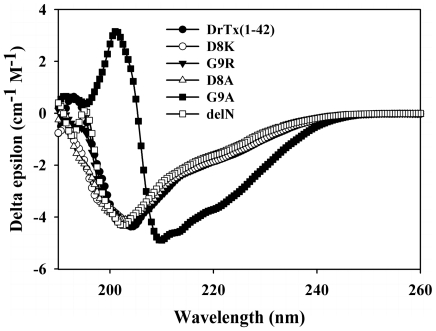
Circular dichroism spectra of DrTx(1-42) and its mutants.The measurement was carried out in the UV range of 260–190 nm at 25°C in water on a JASCO J-720 spectropolarimeter by averaging three scans. The protein concentration was 0.3 mg/ml.